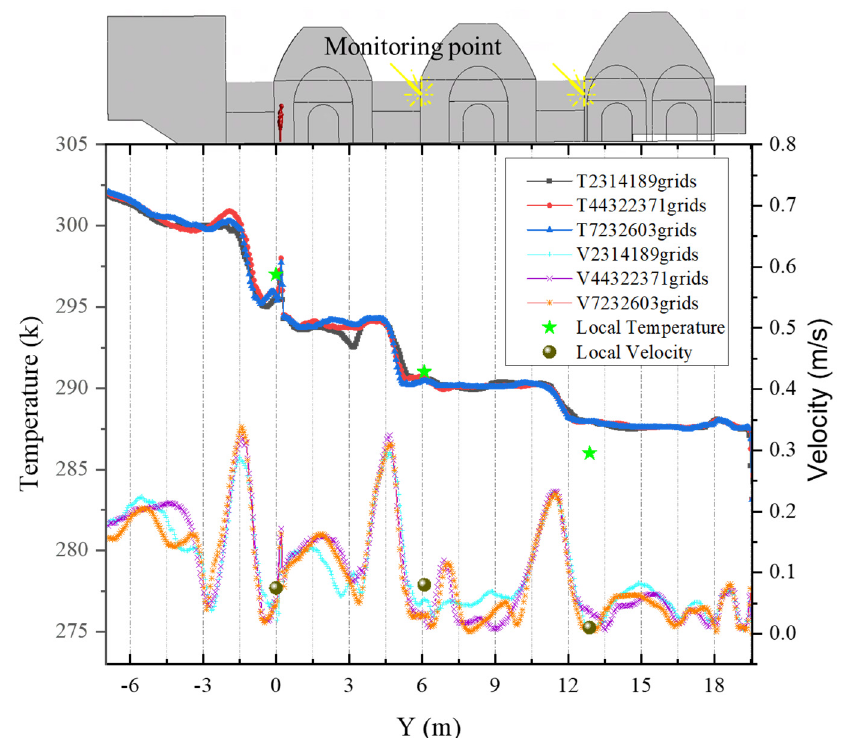
Figure 3. Comparison of simulated wind speed and temperature on the axis Z = 1.8 m with experi- mental values and mesh independence verification.